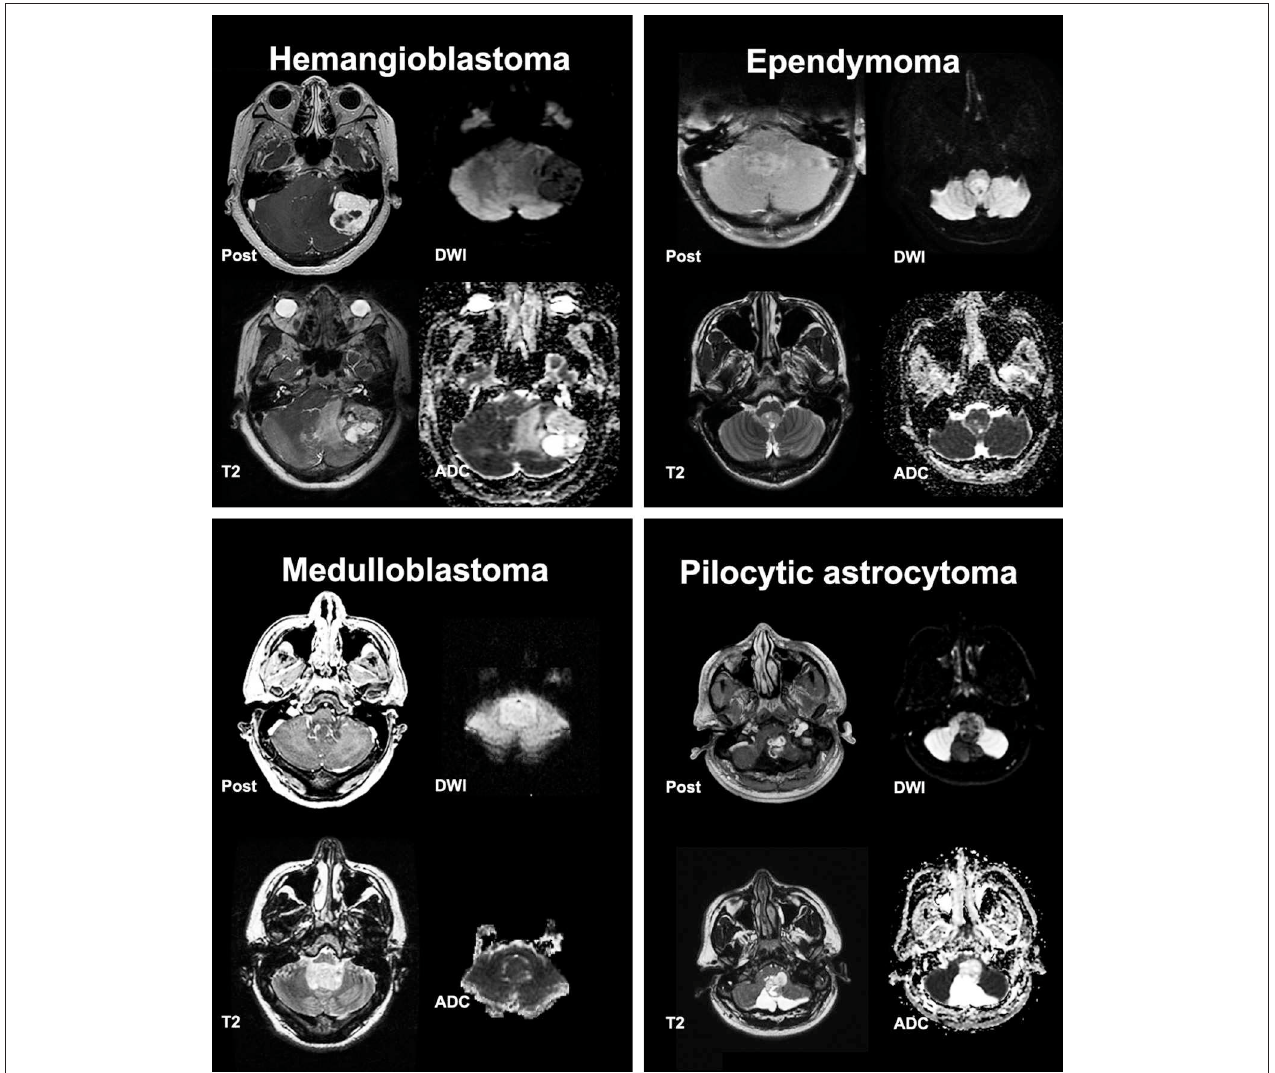
FIGURE 1 | Post contrast T1, T2, Diffusion Weighted Imaging (DWI) and Apparent Diffusion Coefficient (ADC) scans from representative posterior cranial fossa